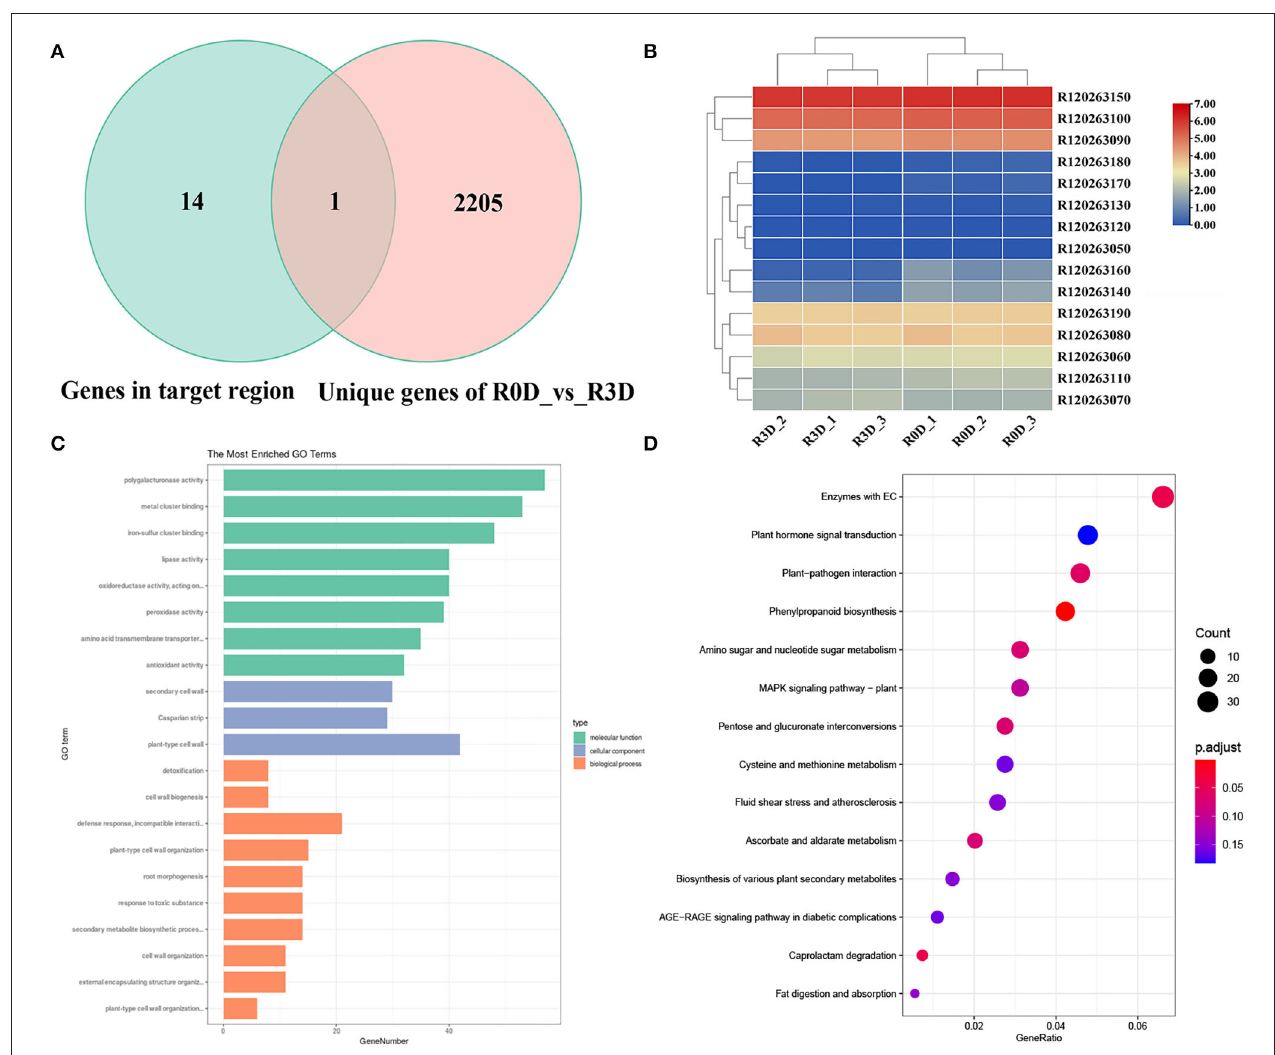
FIGURE 5 | Gene Ontology (GO) enrichment and Kyoto Encyclopedia of Genes and Genomes (KEGG) pathway analyses of DEGs in clubroot resistant radish. (A) The Venn diagram of 2,206 unique DEGs in the comparison between R0D and R3D and genes in the RsCr6 locus. (B) Heatmap of a target region in the RsCr6 locus. Expression levels were calculated using log2-scaled TPM values. TPM, transcripts per kilobase of exon model per million mapped reads. (C) GO enrichment analysis of 2,206 unique DEGs in the comparison between R0D and R3D. (D) KEGG pathway analysis of 2,206 unique DEGs in the comparison between R0D and